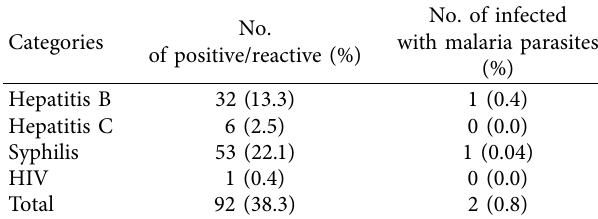
Table 3: Prevalence of malaria parasitemia in examined dis- qualifed donor